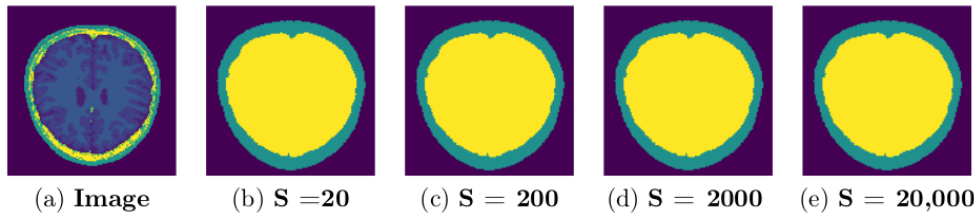
Figure 16. A representative axial section from 3D MRI showing the separation of components for different sample size: MRI from a single subject (BW data set) experimented without threshold, different size of the sampled nodes. GUBS is run on 3D and for visualization we take 2D at the same location for all